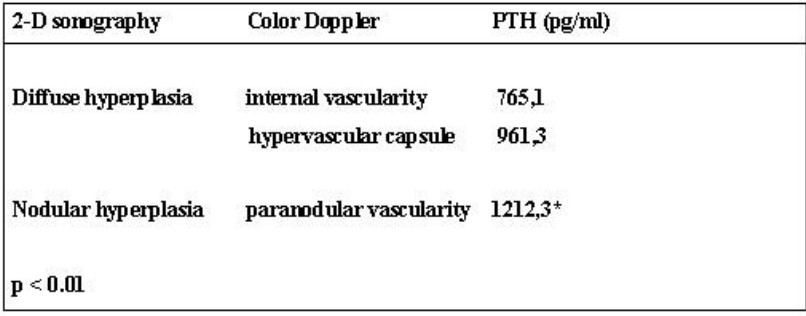
In 58 (48%) patients, uniform echoes, i.e., diffuse hyperplasia of the PTG, were found; 34 patients (28%) had a nodular pattern of the PTG; and in 28 patients (23%), we detected degenerative changes of the PTG. By use of color Doppler sonography, paranodular vascularity was found only in PTGs with nodular hyperplasia (38%), while in diffuse PTG hyperplasia, hypervascularity was found in 22%, internal vascularity in 28%, and no vascularity in 12% of PTGs. We observed the higher PTH level in patients with nodular hyperplasia and paranodular vascularity of the PTG, i.e., PTH was 1212.3 pg/ml, than in patients with diffuse hyperplasia and internal vascularity (PTH 765.1 pg/ml) or hypervascular